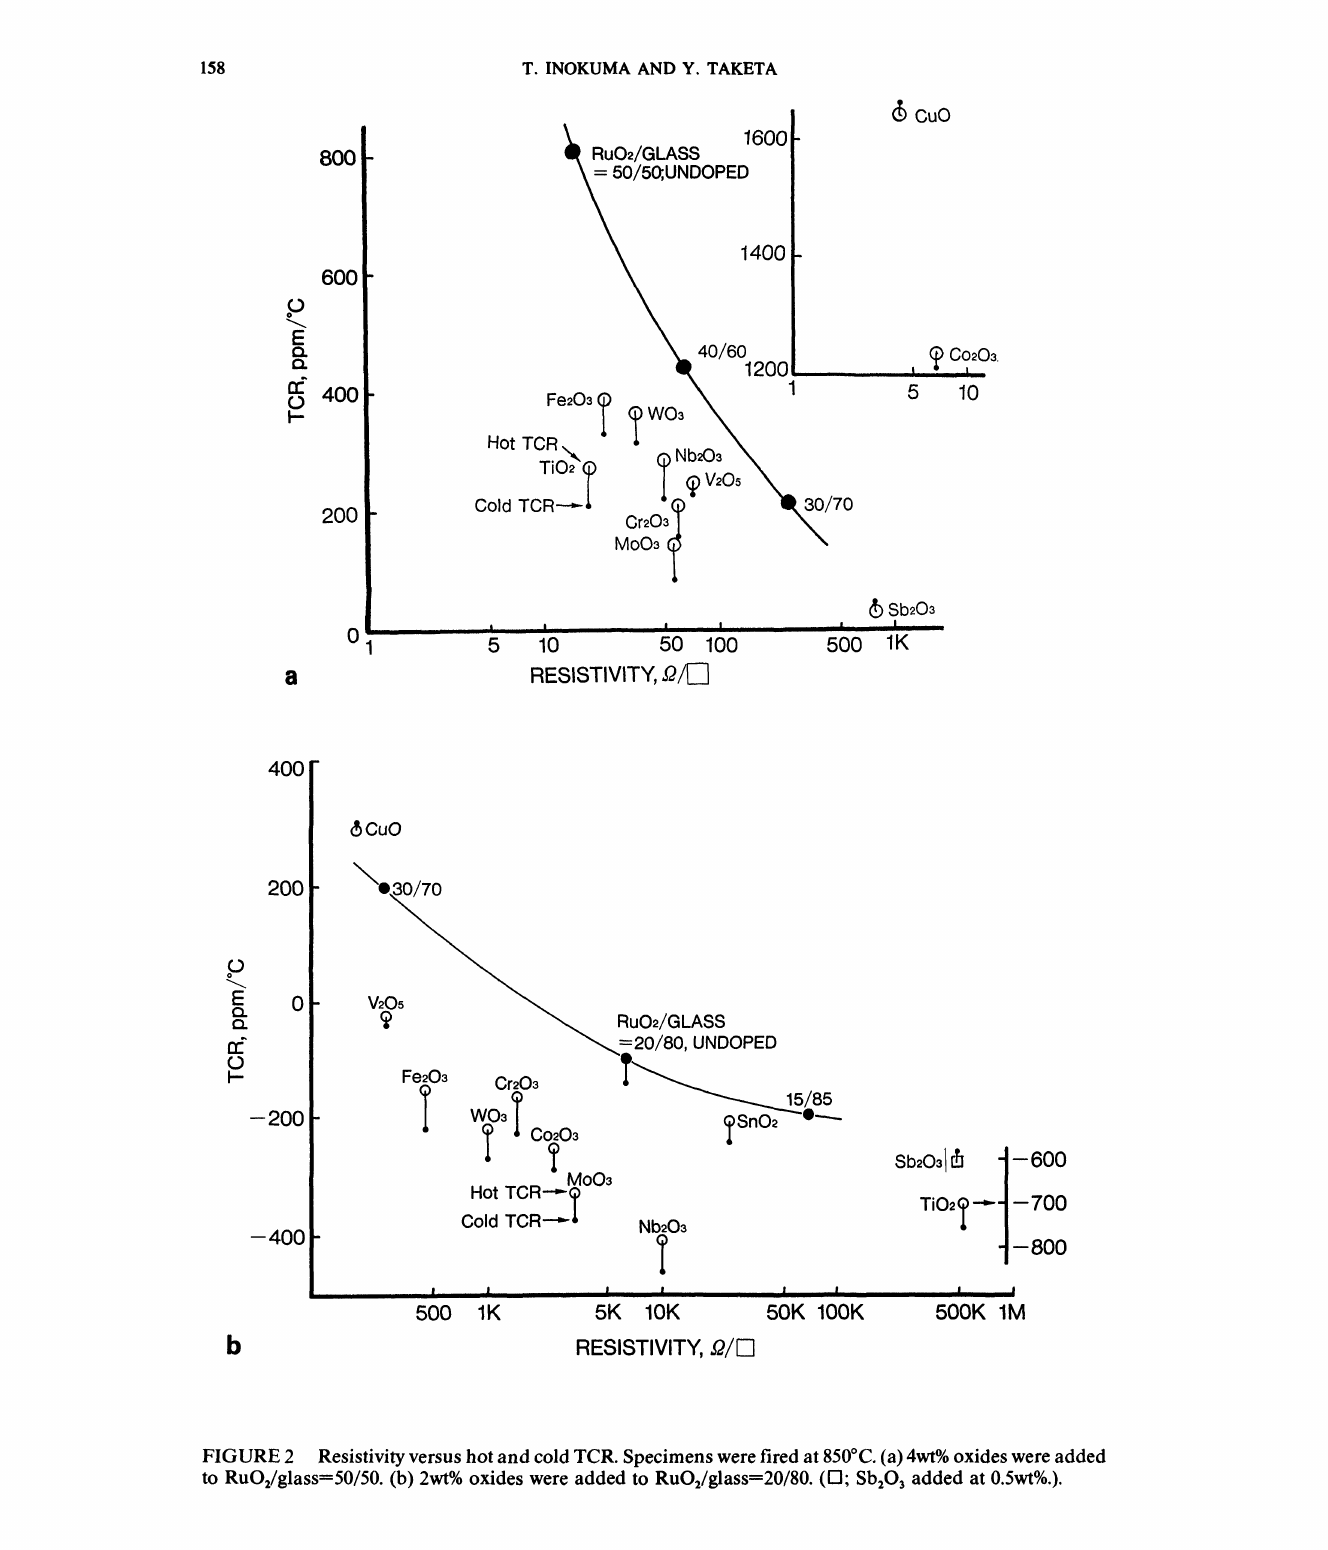
FIGURE 2 Resistivity versus hot and cold TCR. Specimens were fired at 850C. (a) 4wt% oxides were added to RuO2/glass=50/50. (b) 2wt% oxides were added to RuO2/glass=20/80. (El" Sb20 added at